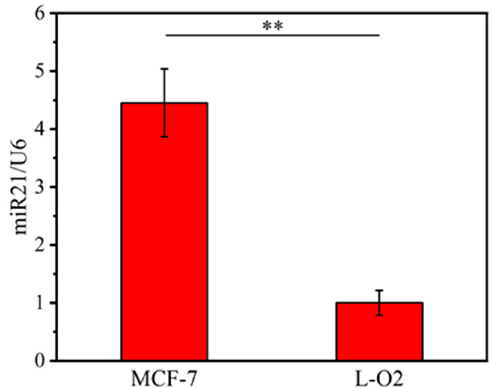
Figure 5. Expression level of miR21 in MCF7 and L-O2 cells. RNA isolated from cells was analyzed by RT-qPCR, and the average expression level of miR21 was normalized to U6 snRNA. Results represent mean ± SD (n = 3). Statistical difference, ** p < 0.01.